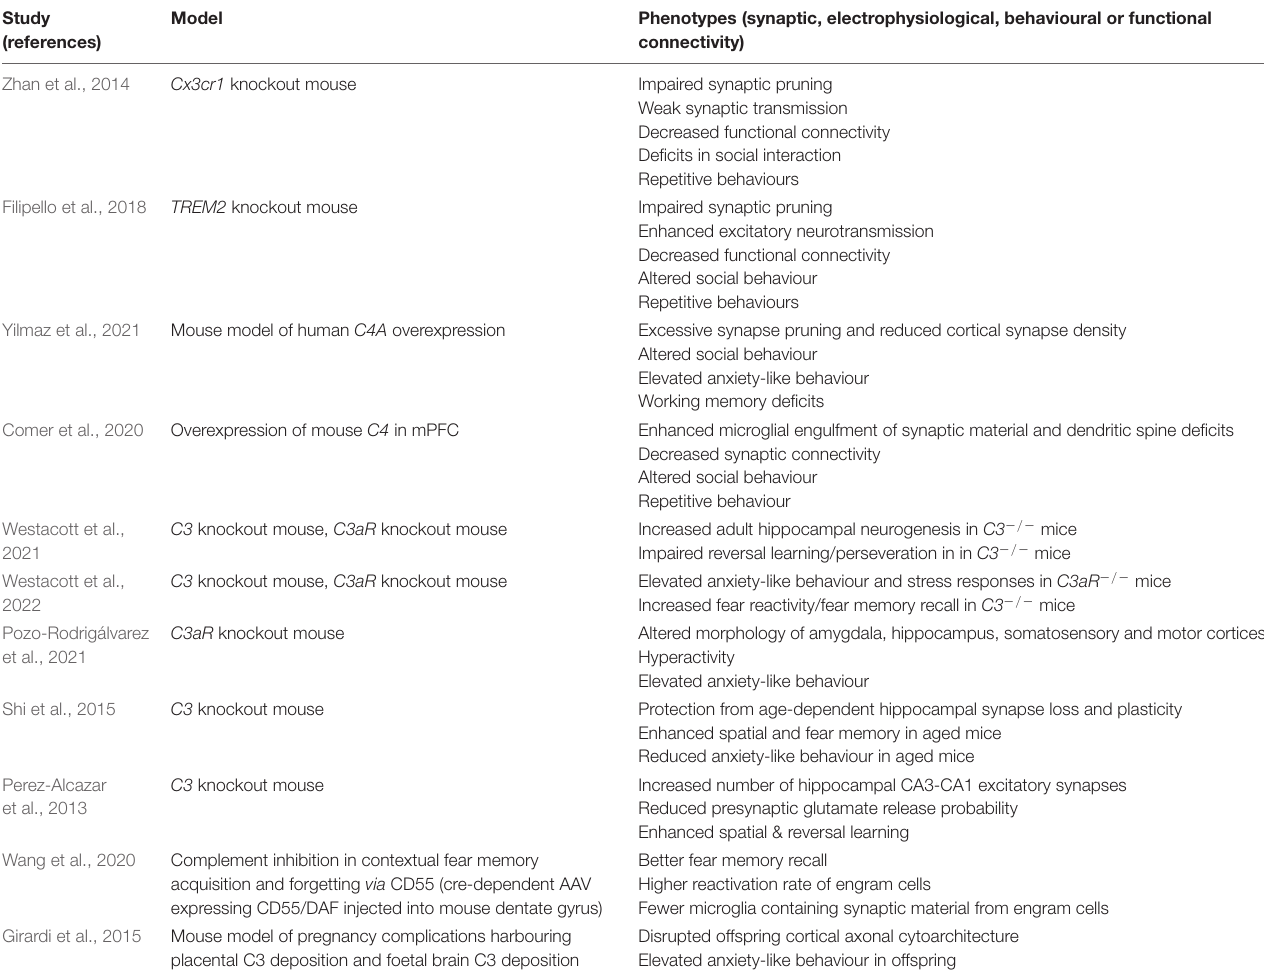
TABLE 2 | Studies reporting manipulations of complement or microglial pathways implicated in developmental synaptic